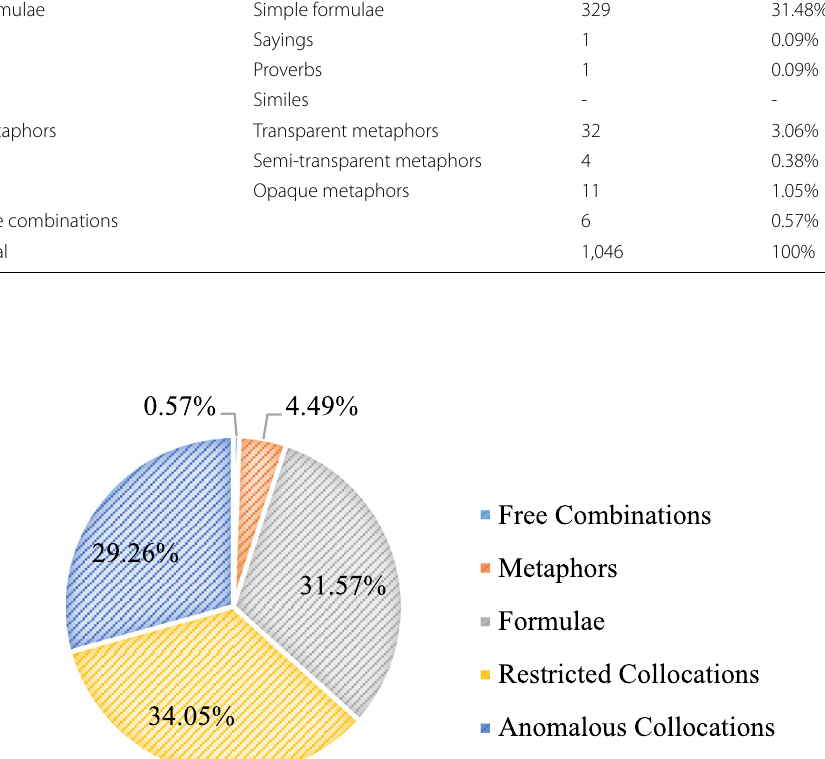
Fig. 3 Percentages of each phraseological unit used in IELTS task 2 w